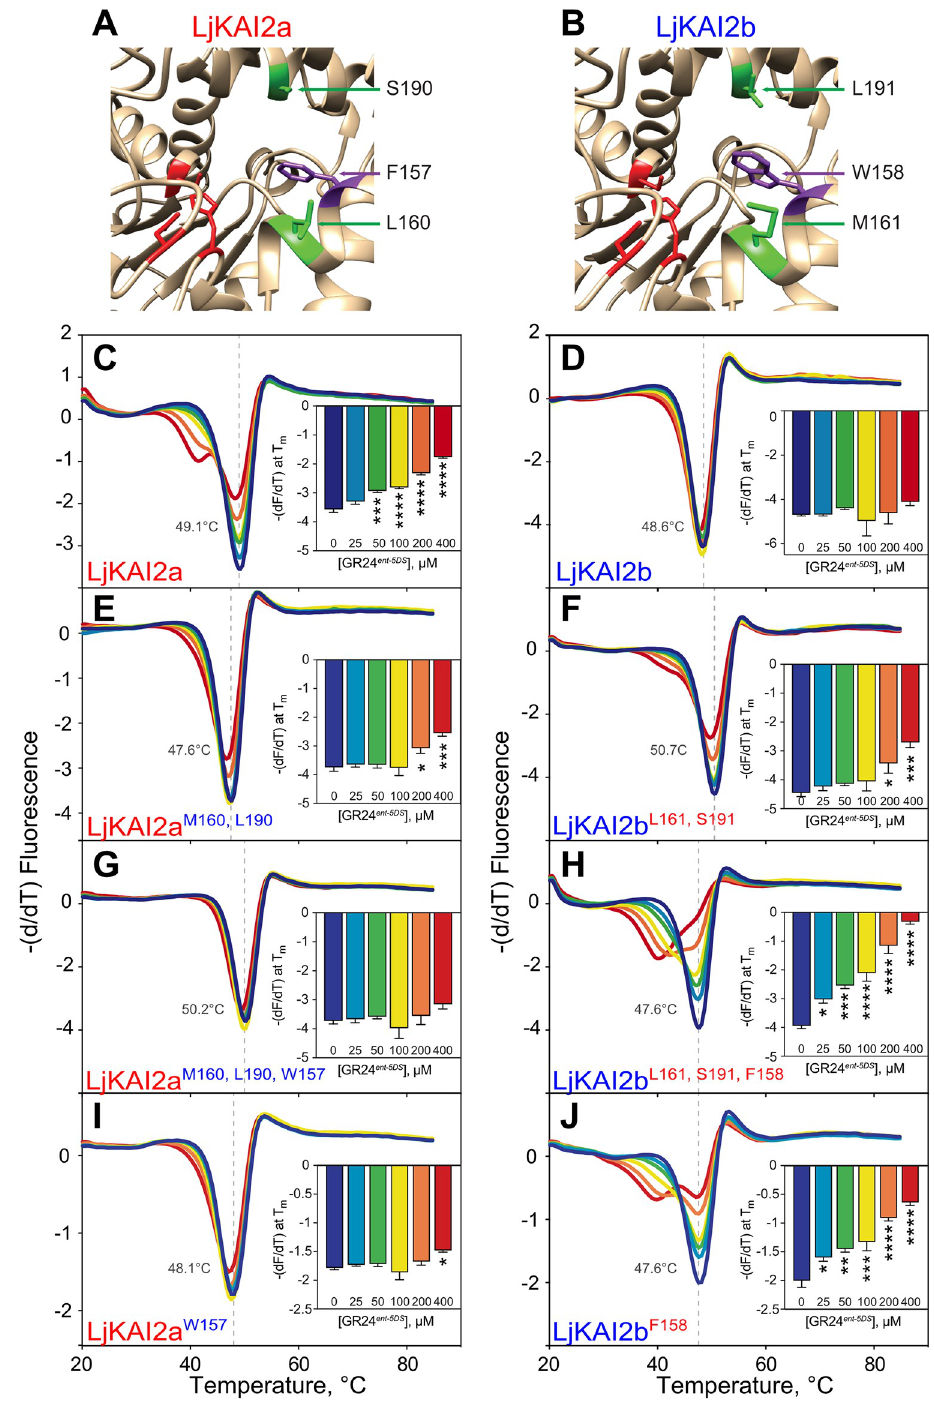
Fig 4. Binding of GR24 ent-5DS to Lj KAI2a is determined by three amino acids. ( A-B ) The ligand-binding cavity regions of Lj KAI2a and Lj KAI2b proteins after structural homology modelling on the KAI2 crystal structure of A . thaliana [5]. Conserved residues in the cavity that differ between the KAI2a and KAI2b clades, and that are also different between Lj KAI2b and At KAI2, are shown in green. The phenylalanine residue in Lj KAI2a, which is changed to tryptophan in Lj KAI2b, is shown in violet. The catalytic triad is coloured in red. ( C - J )DSF curves of purified SUMO fusion proteins of ( C-D ) wild-type Lj KAI2a and Lj KAI2b, and ( E - J ) versions with swapped amino acids ( E-F